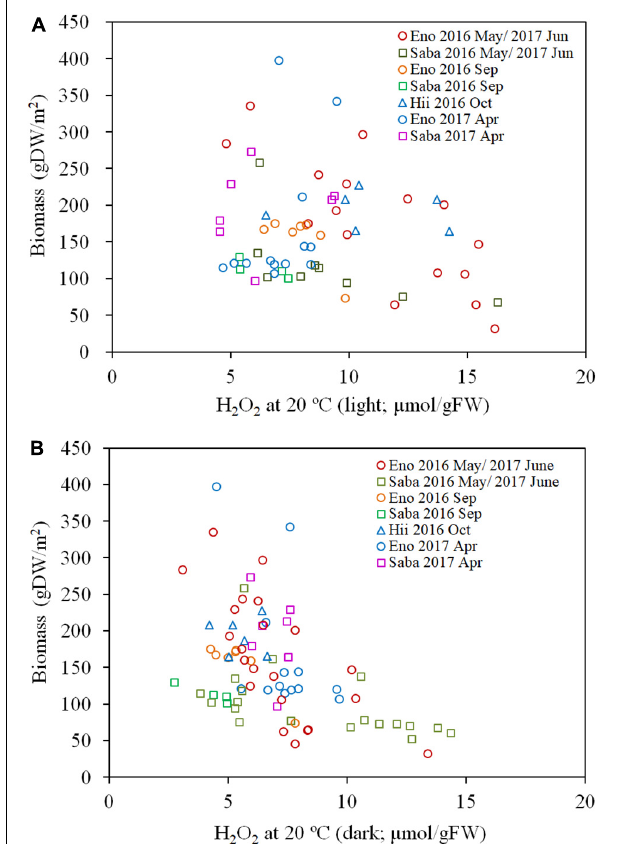
FIGURE 7 | Biomass of E . densa as a function of light exposed H 2 O 2 concentration (A) and dark-adapted H 2 O 2 concentration (B) . The H 2 O 2 concentration was corrected to 20 ◦ C. The sample collected month is represented by the year and the month indicated in the legend. Eno, Saba, and Hii represent Eno, Saba, and Hii rivers, including their tributaries, respectively. ( Figure 8 ). The biomass distribution exhibited a common trend irrespective of the river or the observation